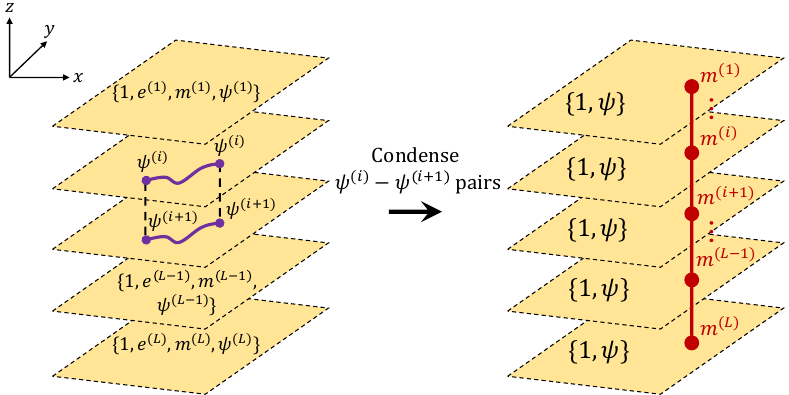
Figure 21: Condensation of the pair of ψ -charges ψ ( j ) ψ ( j + 1 ) in the L layers of (cid:90)